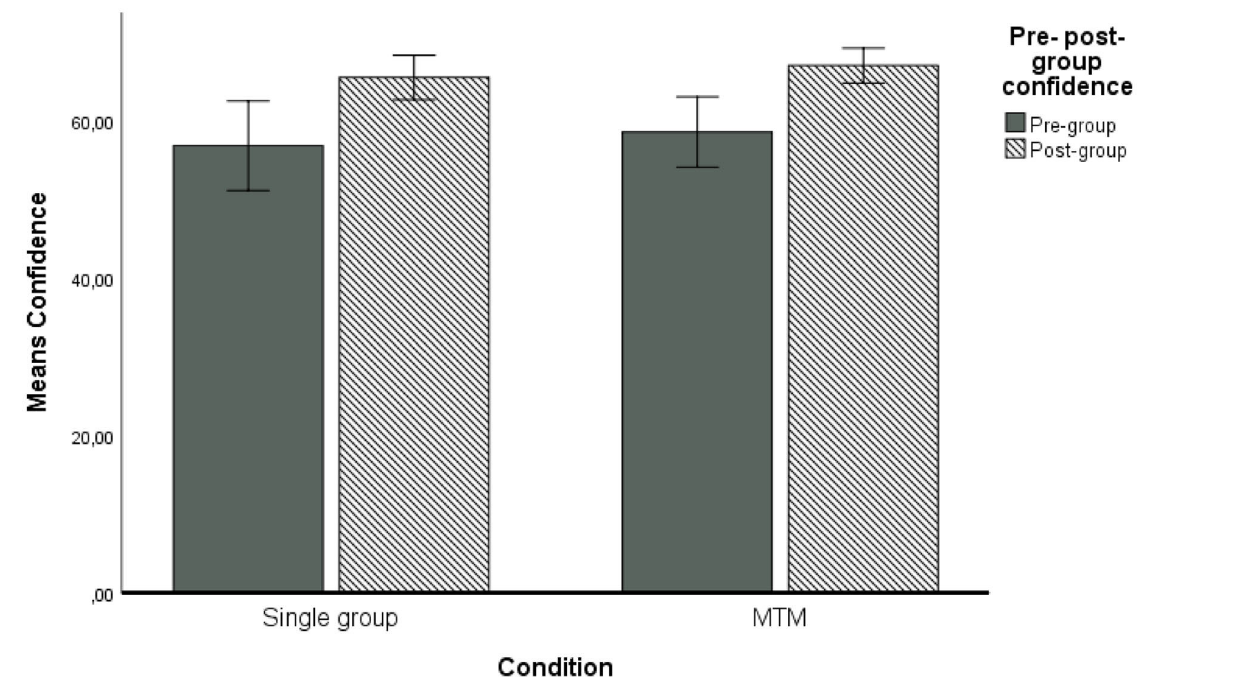
FIGURE 3 | Means confidence in estimates pre- and post-group discussion. Covariates appearing in the model are evaluated at the following values: Age = 20.8095. AVGConGR = 66.5346. NFC = 3.5760. Error bars: 95% CI.